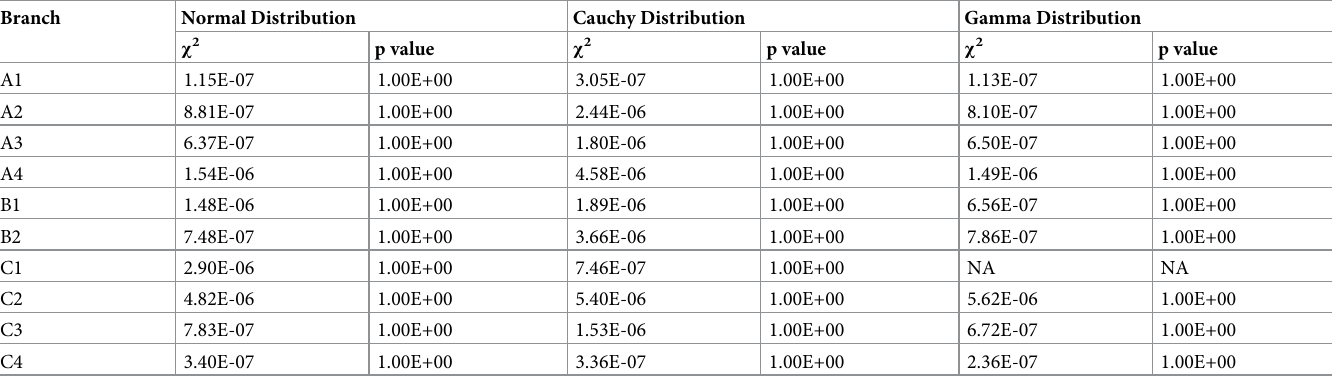
Table 9. Distribution fitting results of cash out (CO) prediction errors.